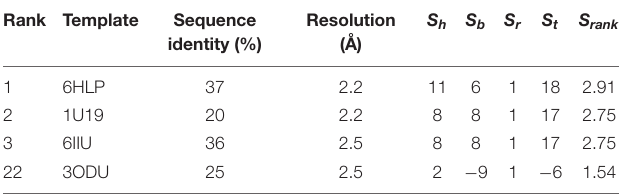
TABLE 3 | Parameters used by Bio-GATS to predict top templates for